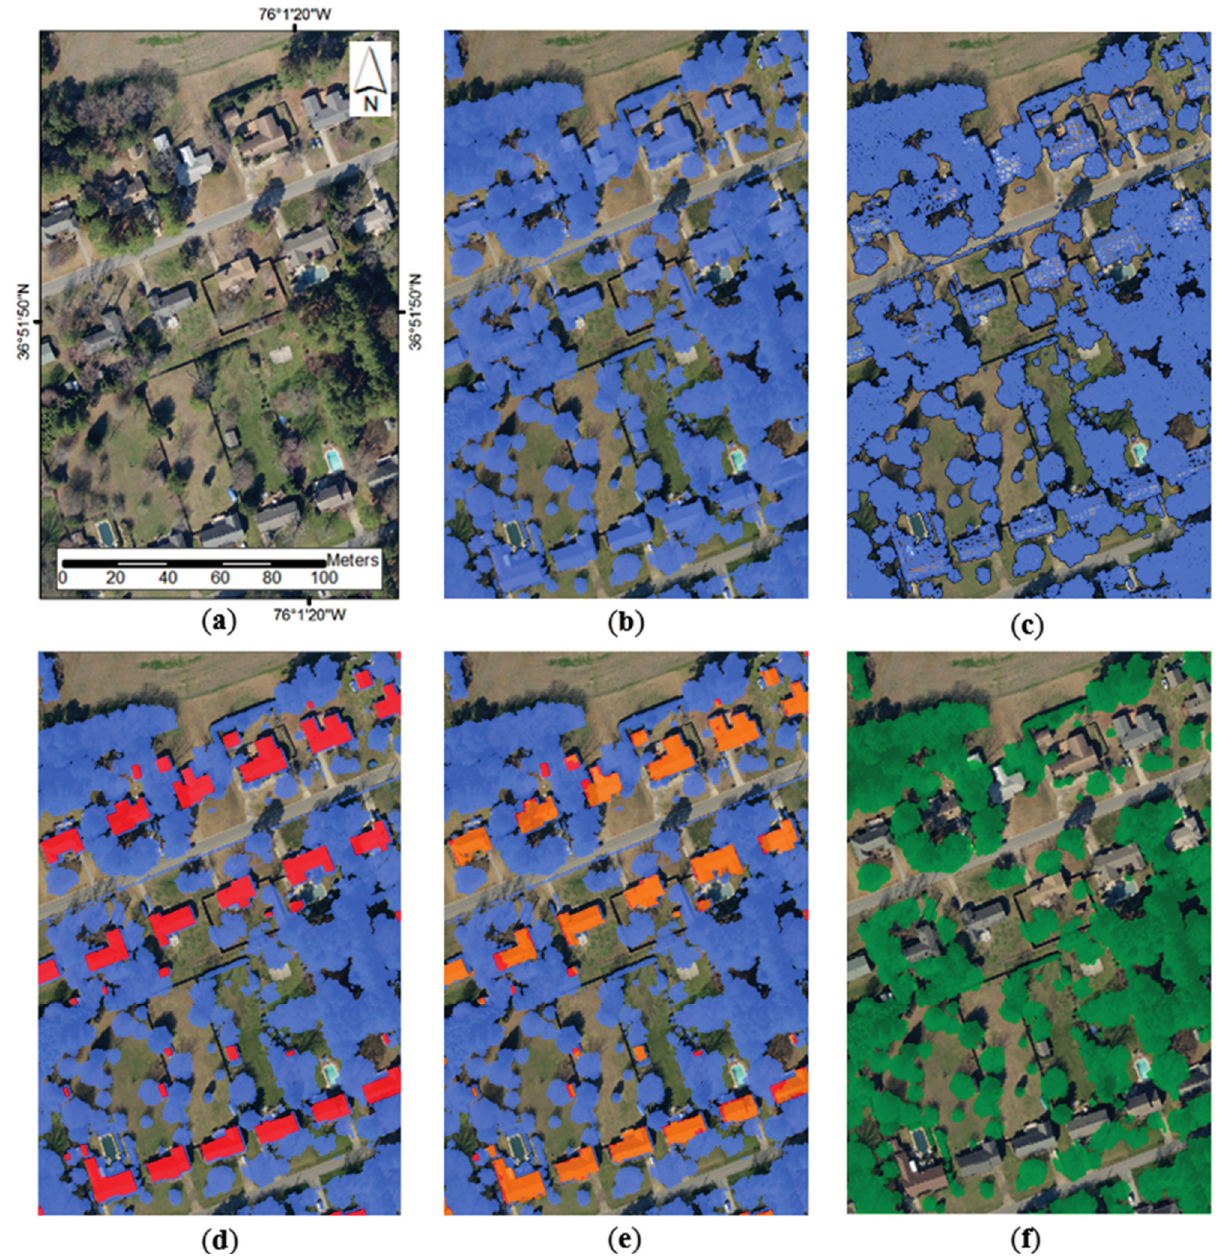
Figure 3. Segmentation workflow for tree canopy mapping using a combination of an nDSM, nDTM, and thematic building footprints. ( a ) A 0.152-m GSD true-color orthoimagery for Virginia Beach, Virginia, USA. ( b ) Initial segmentation of tall objects (temporary class _Temp , in blue) using an nDSM. ( c ) Re-segmentation of tall objects. ( d ) Segmentation and classification of thematic building footprints (red objects). ( e ) Evaluation of thematic buildings for overhanging tree canopy using nDSM/nDTM Difference (overhanging tree canopy in red, uncovered building rooftops in orange). ( f ) Final Tree Canopy class after error checking and morphological